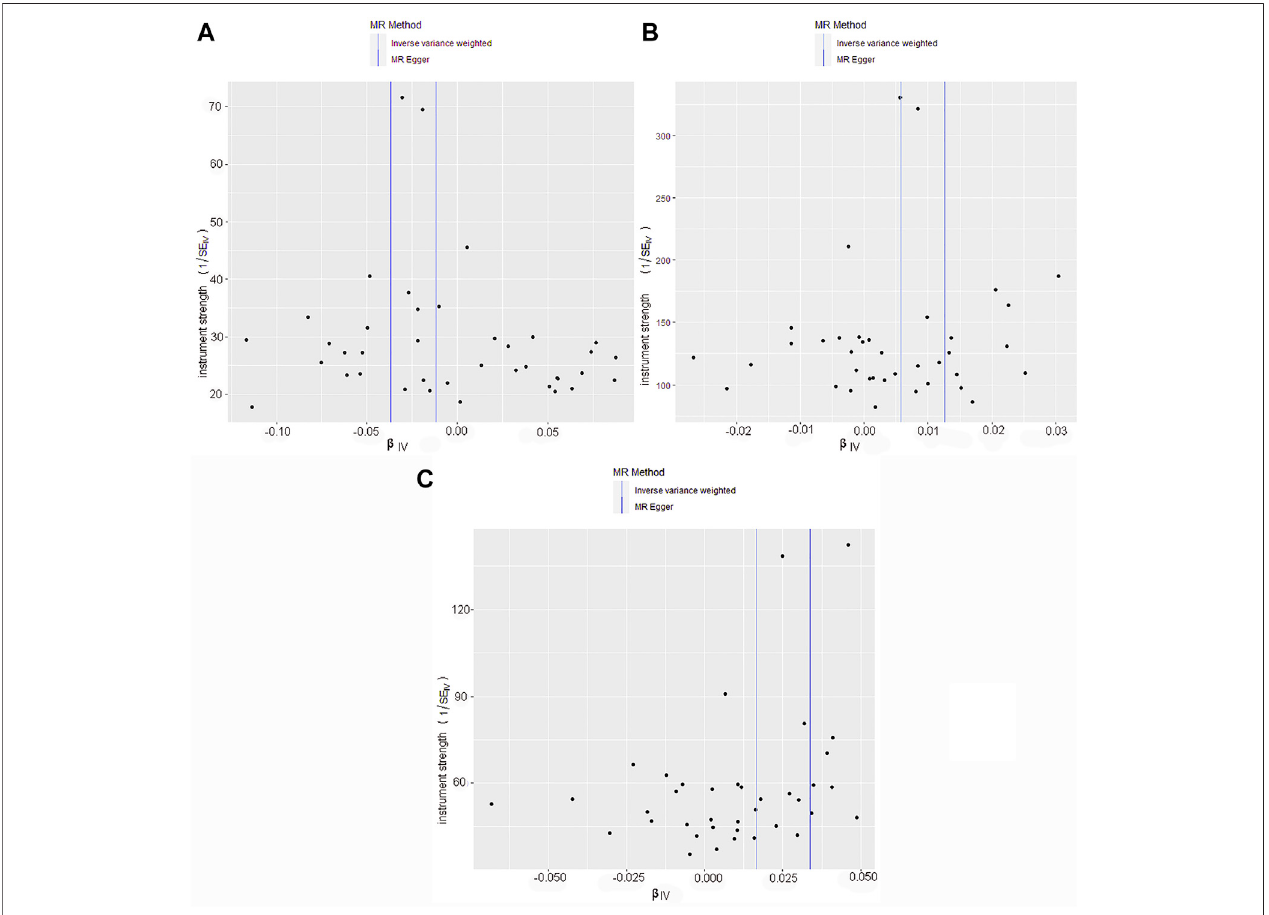
FIGURE5| FunnelplotofskincancerandagingriskbasedonTLgeneticvariants. (A) Skinaging; (B) Melanoma; (C) NMSCs.Causaleffectswereexpressedaslog odds ratios for skin aging and skin cancer per unit shortening of telomere length. Overall causal estimates (beta coef fi cients) of telomere length and skin aging and skin cancer estimated by the IVW (light blue line) and MR-Egger (dark blue line) methods are shown.